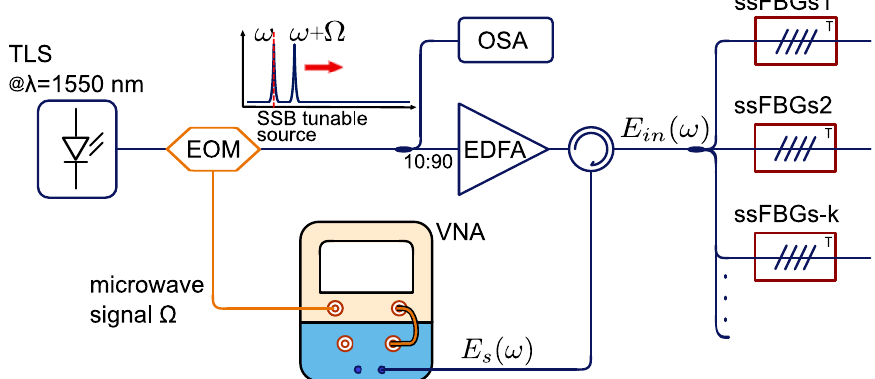
Figure 3. Interrogation setup to measure the frequency response of the sensing network. A dual-wavelength scanning source E in is created by the single side band modulation of a tunable laser at 1550 nm. The reflected waves from the sensing array E s are measured at the vectorial network analyzer (VNA) to compute the sensing network frequency response at the fixed microwave frequency Ω . OSA: optical spectrum